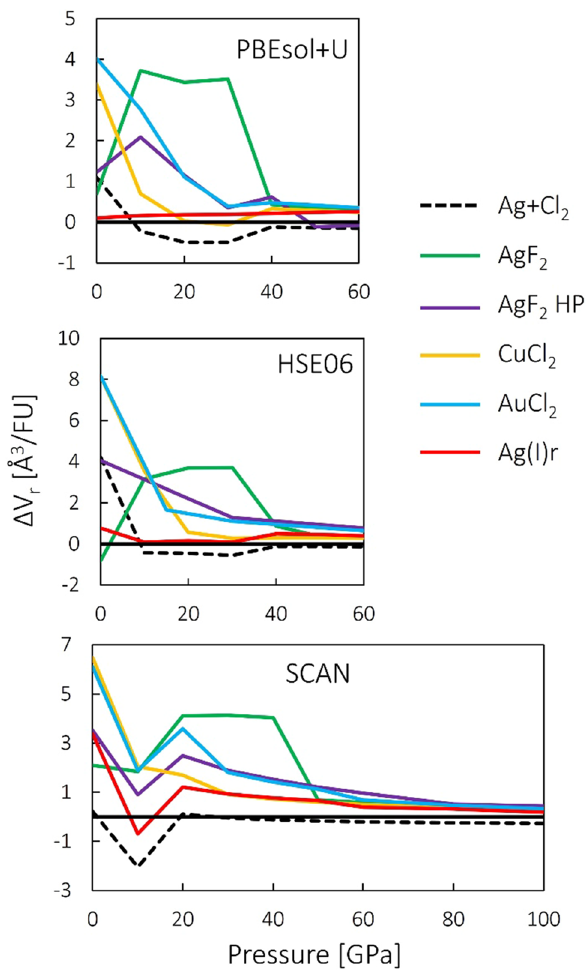
Figure 3. Volume of selected studied polymorphs of AgCl 2 relative to AgCl + ½Cl 2 . Top panel—PBEsol + U, middle panel—HSE06 (hybrid functional), bottom panel—SCAN (meta-GGA functional). FU formula